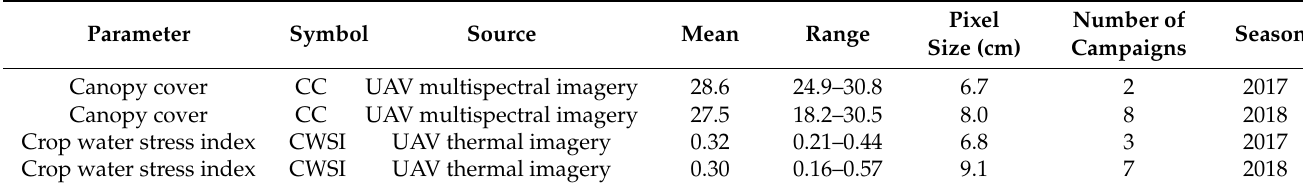
Table 2. Descriptive statistics of variables based on remote sensing retrievals.